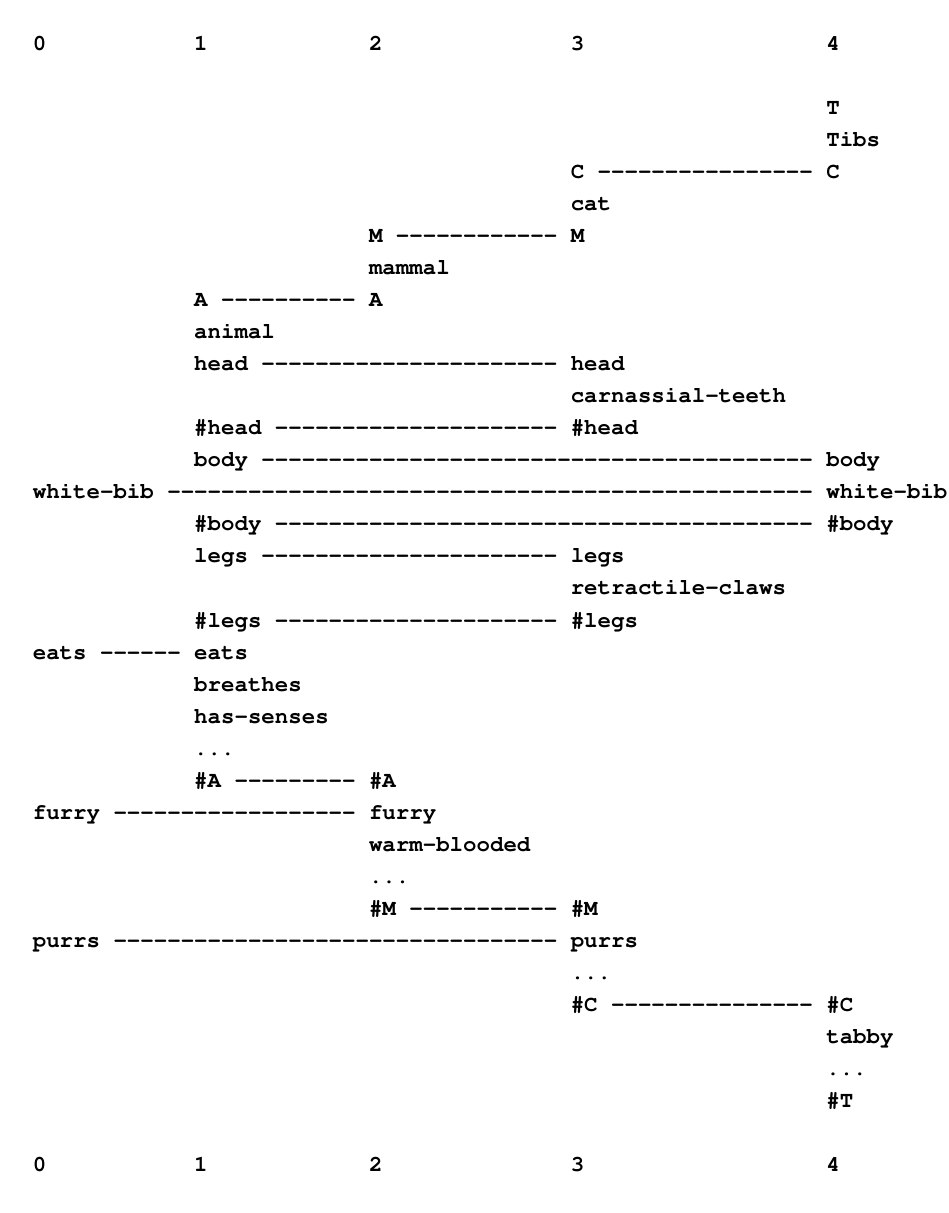
Figure 15. The best multiple alignment found by the SP model, with the New pattern “ white-bib eats furry purrs ” and a set of Old patterns representing different categories of animal and their